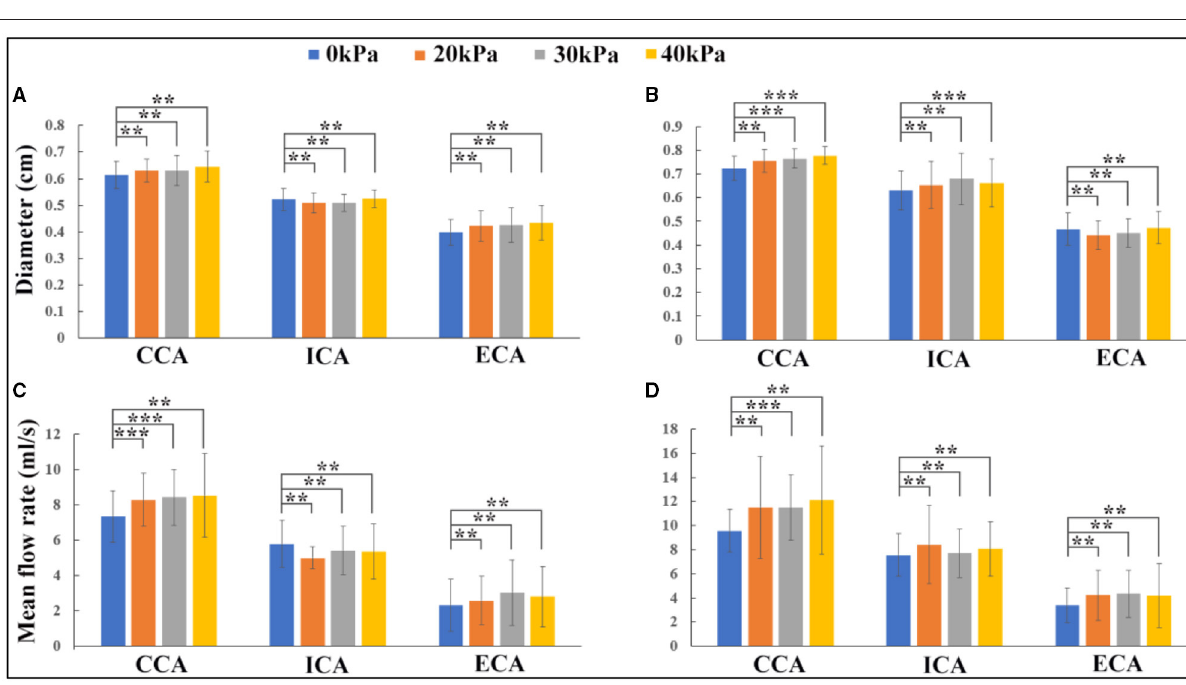
FIGURE 3 | Effects of enhanced external counterpulsation (EECP) on lumen diameter and blood flow rate in carotid artery: (A) lumen diameter variations in the healthy control group; (B) lumen diameter variations in the patient group; (C) blood flow rate variations in the healthy control group; (D) blood flow rate variations in the patient group (**indicates P > 0.05, ***indicates P ≤